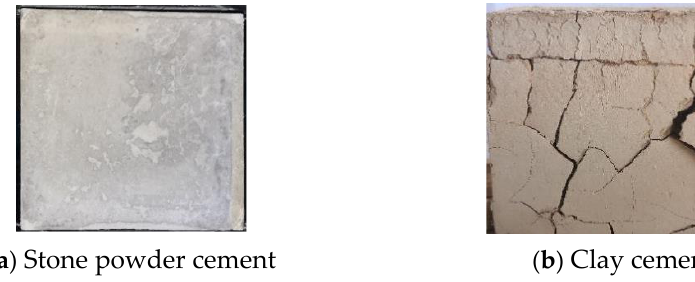
is preferred for geotechnical reinforcement slurry material.